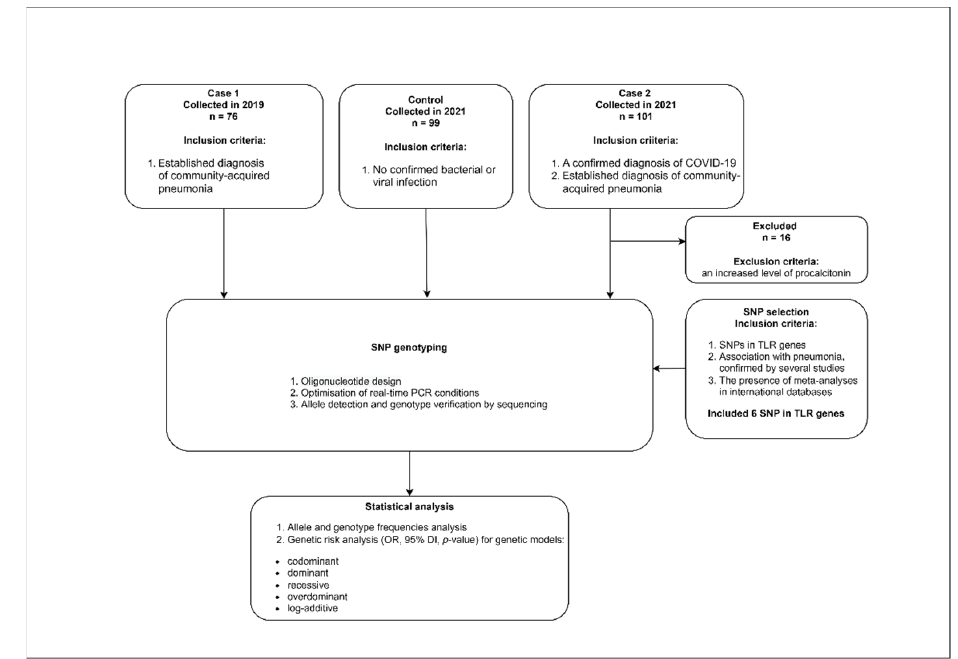
Figure 1. Study design.